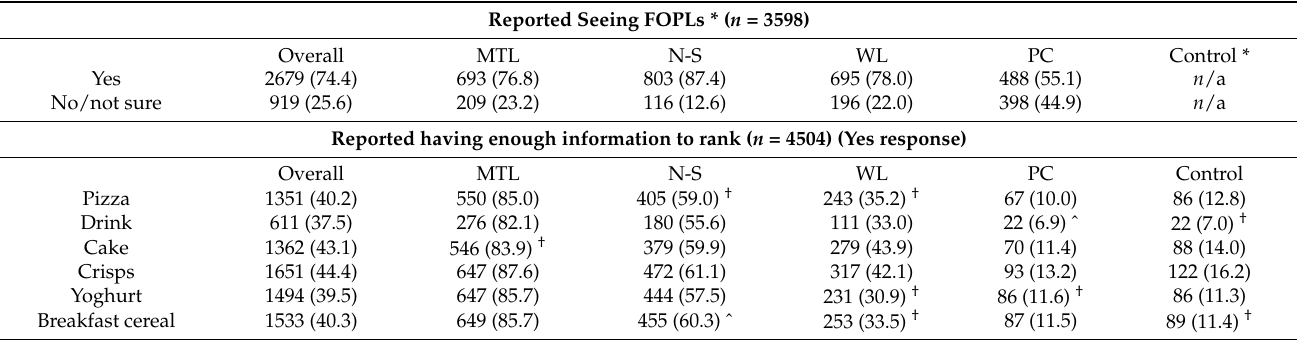
Table 2. Results of post-ranking questions at follow-up across the study sample, ( n = 4504).